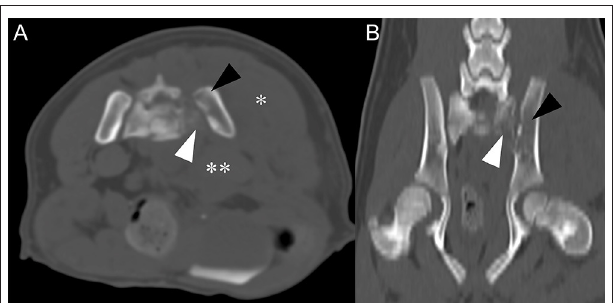
FIGURE 2 | Transverse plane, pre-contrast CT image (A) and dorsal plane, pre-contrast CT image (B) in bone algorithm at the level of sacroiliac joint level. (A) Compared to right sacrum and ilium, left sacrum (white arrowhead), and ilium (black arrowhead) have relatively low attenuation and indistinct bone margins. Left gluteal (asterisk) and sublumbar muscle (double-asterisk) show marked swelling and increase in thickness. Note widening of retroperitoneal space. (B) Low attenuation of left sacrum (white arrowhead) and ilium (black arrowhead) are